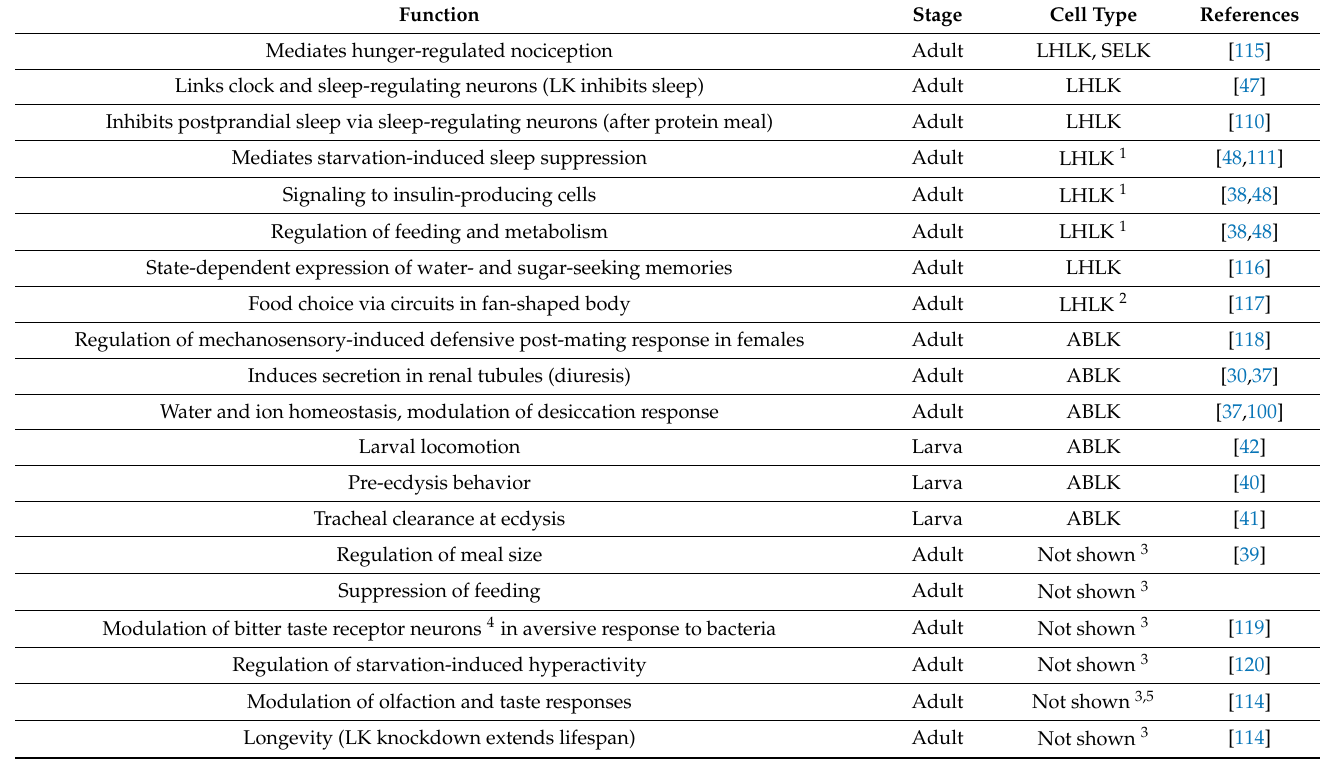
Table 2. Functions of LK signaling and specific LK neurons in